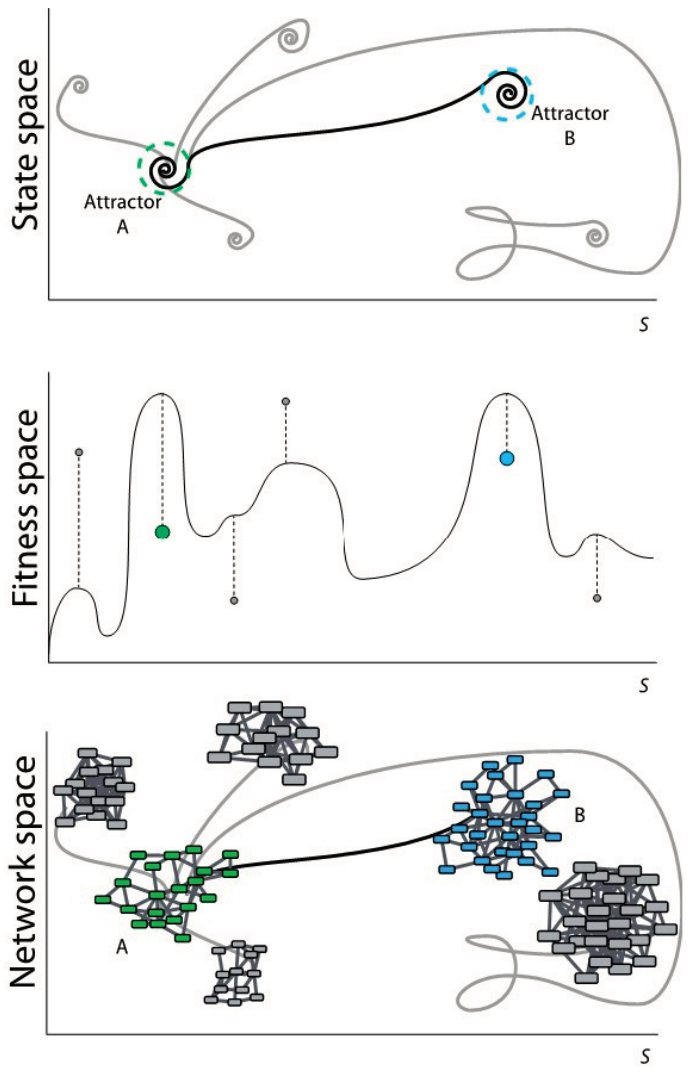
Figure 1. Scheme of evolutionary dynamics from three different perspectives. ( Top ) From the perspective of dynamical systems; ( Middle ) From the perspective of the evolutionary process; ( Bottom ) From the perspective of networks